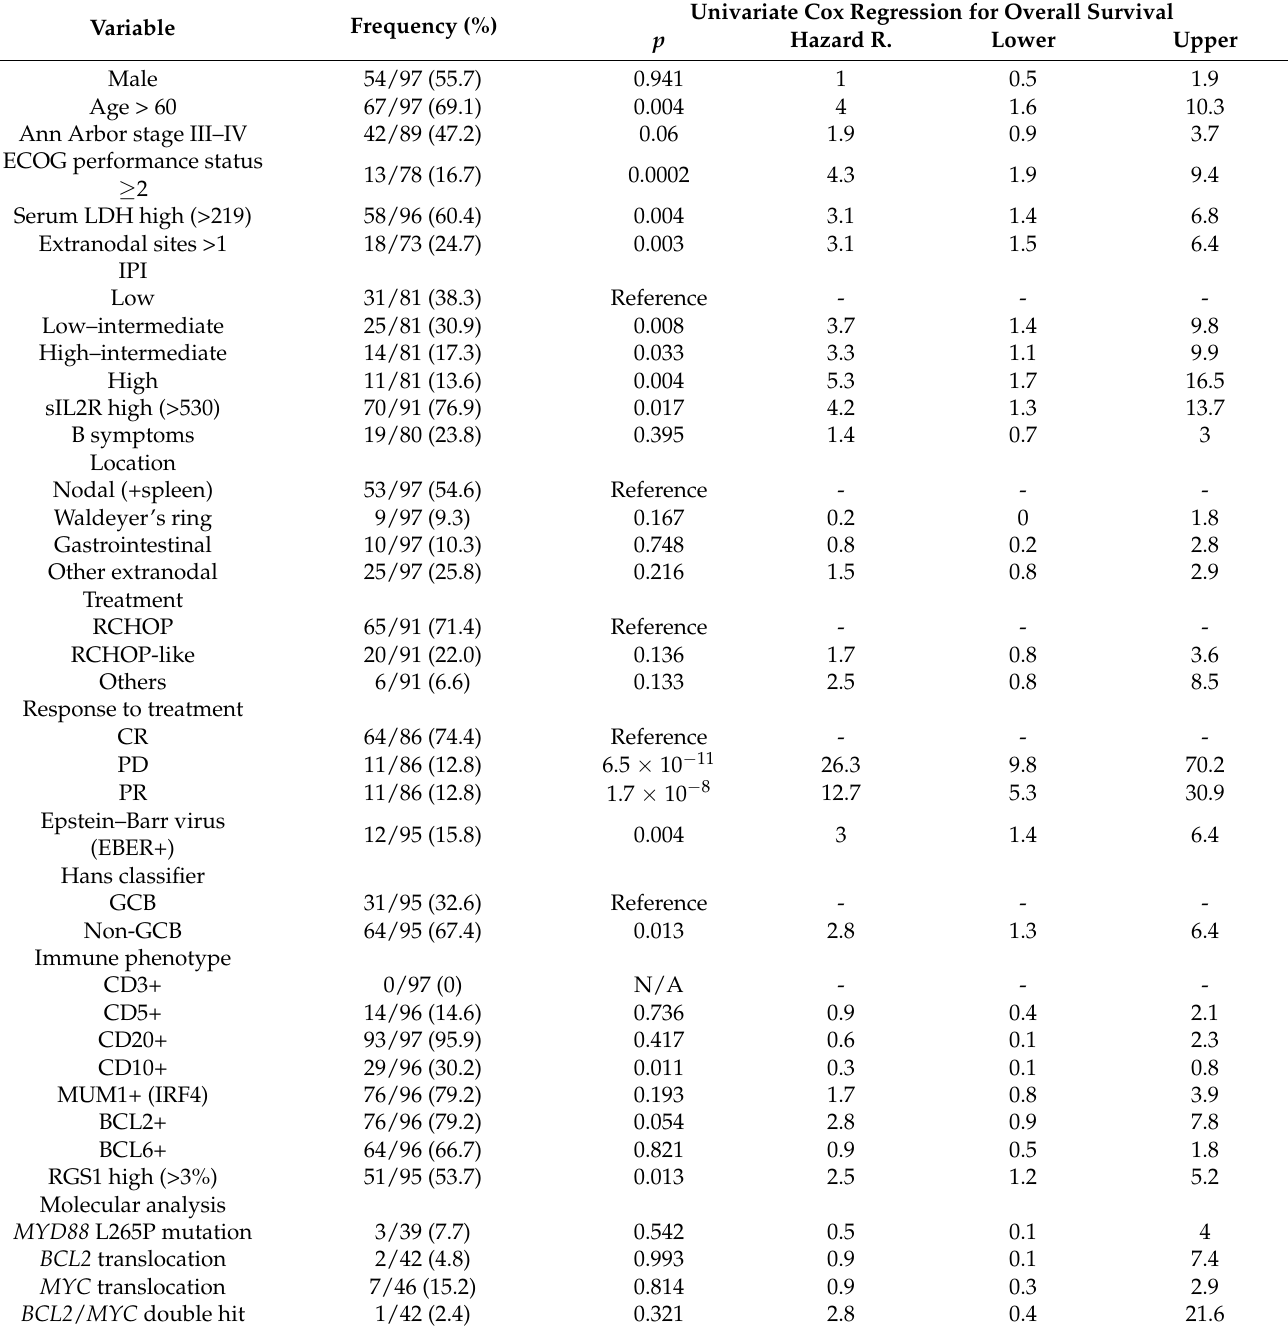
Table A5. Characteristics of the series of DLBCL used in the immunohistochemical